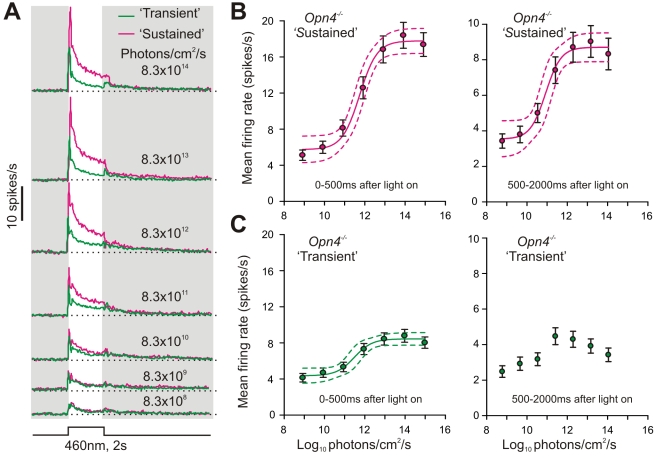
Melanopsin is necessary for encoding high irradiances.(A) Mean response to 2 s blue light pulses from the 40% most “sustained” and remainder 60% most “transient” Opn4
−/− LGN neurons (as defined by their response to bright 60 s light steps; n = 87 and 130, respectively). (B,C) Quantification of the firing rate of Opn4
−/− “sustained” (B) or “transient” (C) LGN cells during the first 500 ms (left) or remainder (500–2000 ms; right) of the light pulse. Symbols indicate mean ± SEM, and lines indicate mean ±95% CI of the function that best described the data. Note that, unlike Opn1mwR “sustained” cells, both “sustained” and “transient” Opn4
−/− populations display sigmoidal relationships between firing rate and irradiance, which saturate above 1012 photons/cm2/s. Data for “transient” Opn4
−/− cells over 500–2,000 ms of the response were not well fit by either linear or sigmoidal functions.